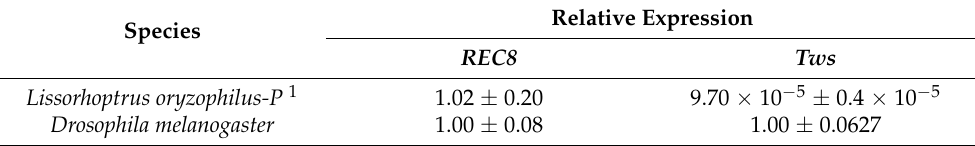
Figure 3. Quantification of REC8 and Tws in RWW ovarian tissues with bisexual reproductive ISOCS as reference. The y -axis indicates the relative expression (for details see Table 1, β-actin as internal reference). Error bars are s.d., n = 3. ** p < 0.01 ( t -test). Table 1. Q-PCR results.